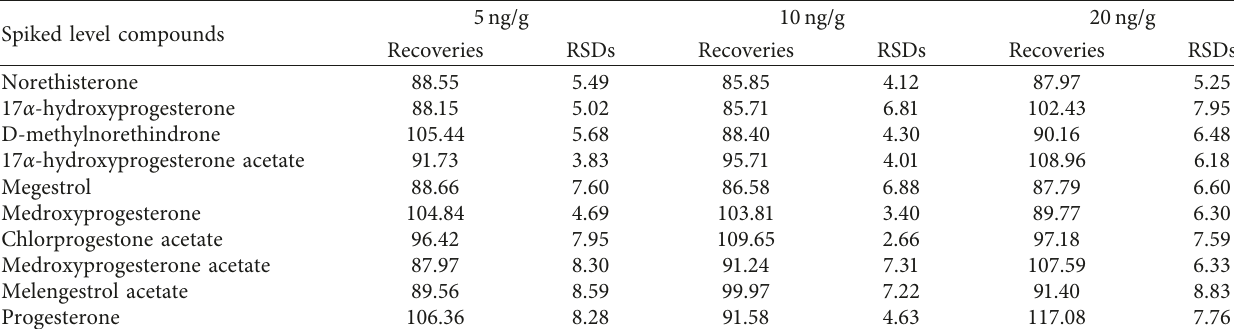
Table 3: Recoveries and relative standard deviations (%) of 10 progestins in fish ( n � 7). Spiked level